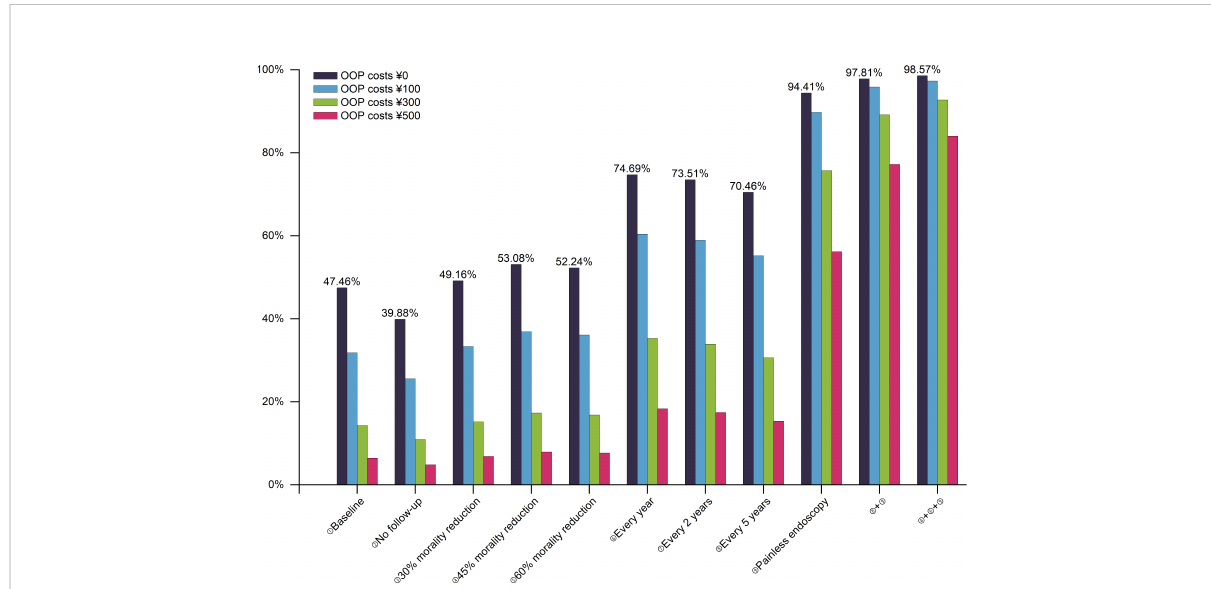
FIGURE 2 The participation rates for UGC screening at different levels of out-of-pocket costs. Baseline: once in a lifetime, with follow-up, a 15% mortality reduction, and endoscopy; UGC, upper gastrointestinal cancer; OOP,